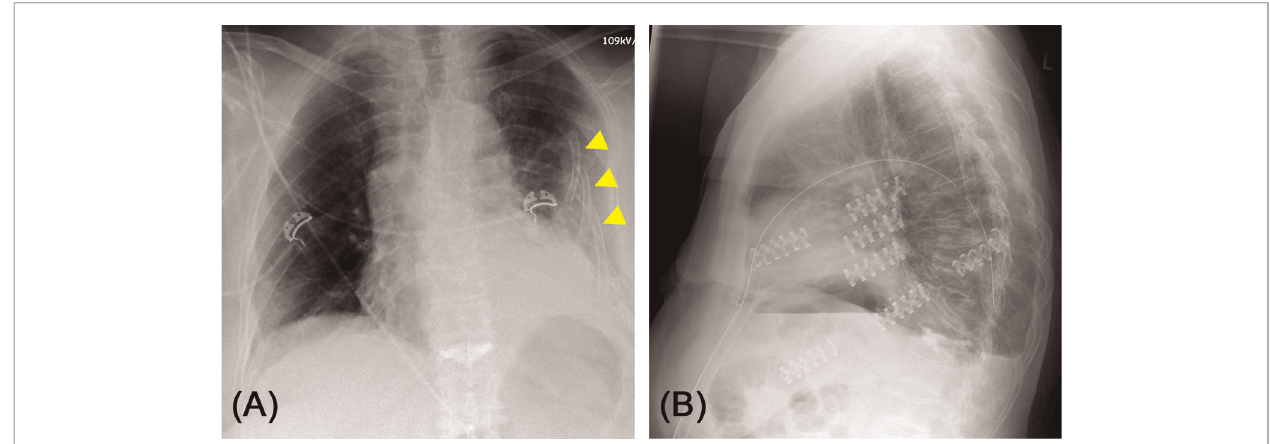
FIGURE 1 | ( A ) Chest X-ray of a 73-year-old female patient after home accident. Signi fi cantly dislocated serial rib fracture of the left side with involvement of all ribs except the 12th rib. Several ribs with multiple fractures causing free fracture segments ( “ fl oating rib ” ). ( B ) Post-operative lateral chest X-ray after osteosynthesis of costae 4 to 7. Not all fractures needed to be fi xated to achieve stabilization of the chest wall and regain physiological contour of the